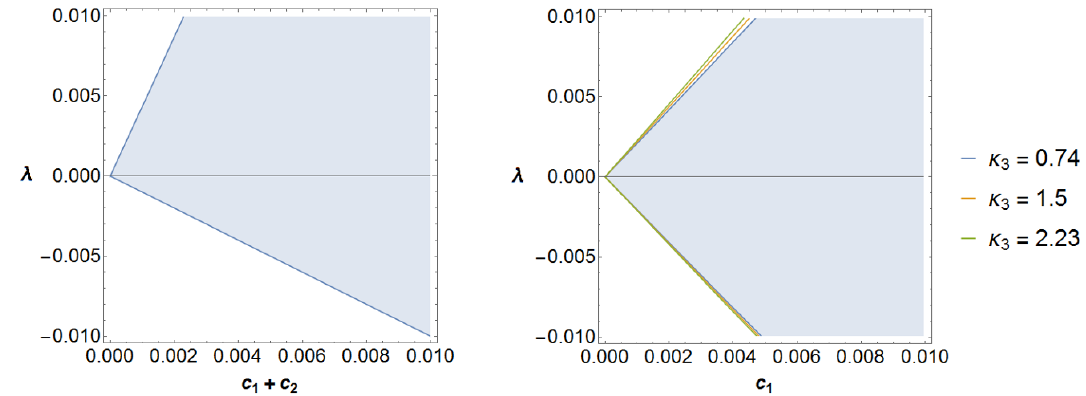
Figure 9 . The allowed regions in the case of suppressed cubic interactions. Left: general case for arbitrary values of x = m 1 =m 2 and (cid:13) = M 1 =M 2 . Right: Z 2 symmetric case, i.e. with x = (cid:13) =